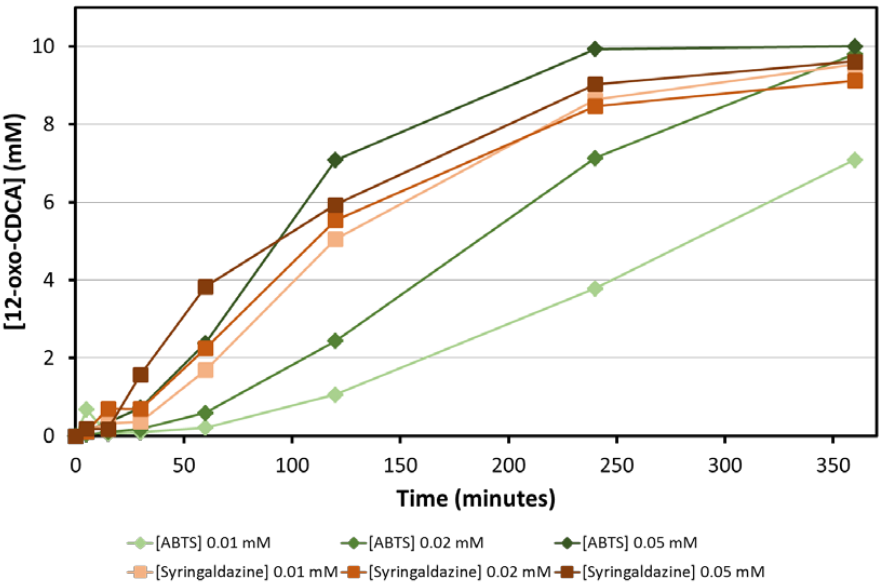
Figure 4. Bioconversion time courses employing El 12α -HSDH coupled with Mt Lac and varying amounts of syringaldazine (red lines) or ABTS (green lines). Reactions were performed in the presence of 10 mM CA, 0.5 mM NADH in 100 mM KPi buffer (pH 8.0) at 25 °C.